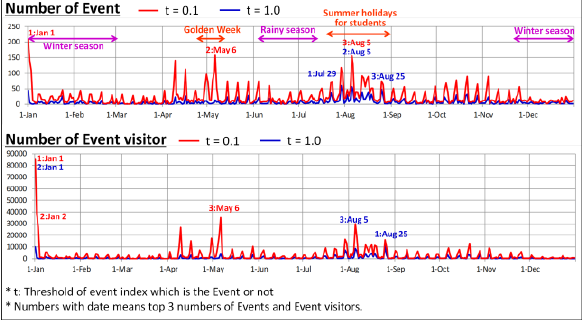
Figure 15. Time-series changes of the number of the Event and Event visitor of each day when the threshold is 0.1 and 1.0.